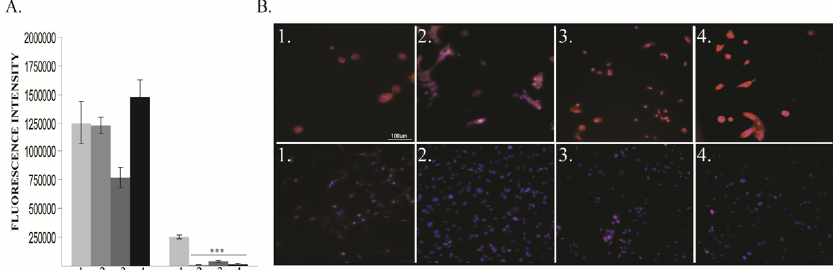
Figure 5. E-Cadherin protein expression. ( A ) Protein quantification: left MCF10A, right MDA-MB-231 ( B ) Immunofluorescence pictures: upper panel MCF10A, lower panel MDA-MB-231; 1 — 21% O 2 , 2 — 40% O 2 , 3 — 60% O 2 , 4 — 80% O 2 . *** p < 0.0005.